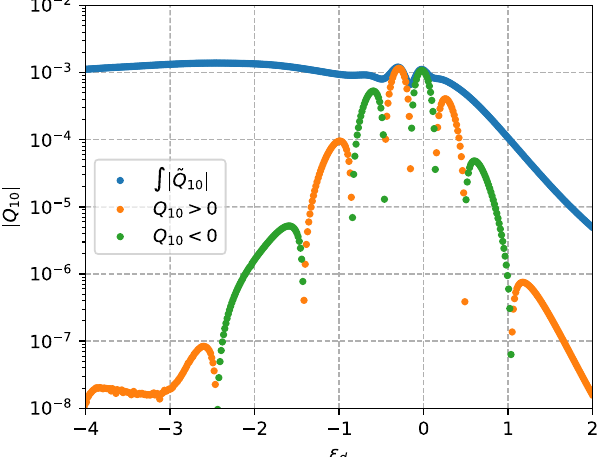
R R ˜ ˜ Q Q and for n ¼ 10 versus ϵ j n ¼ n n j